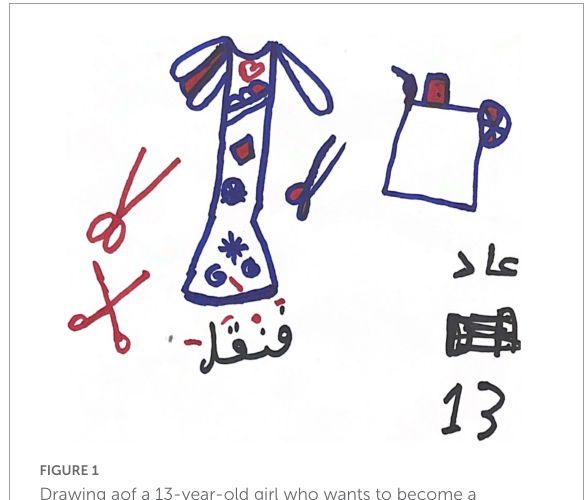
FIGURE2 Drawing by a 16-year-old boy who wants to raise and sell